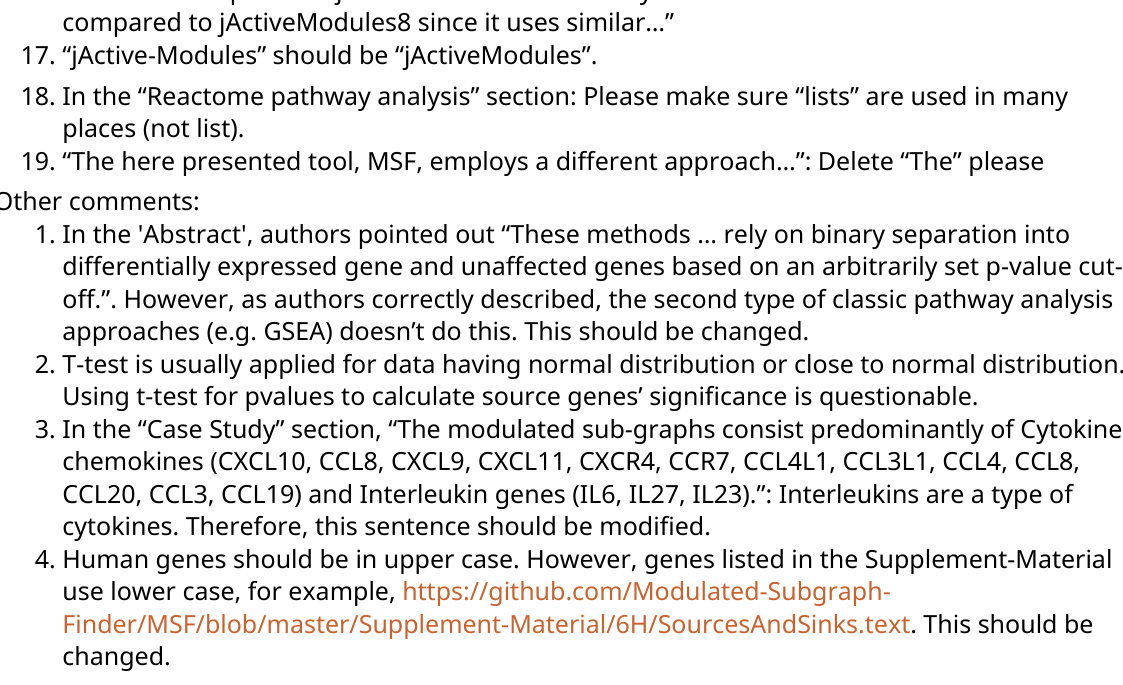
Table 1: “Number of connected sub-graph” should be “Number of connected